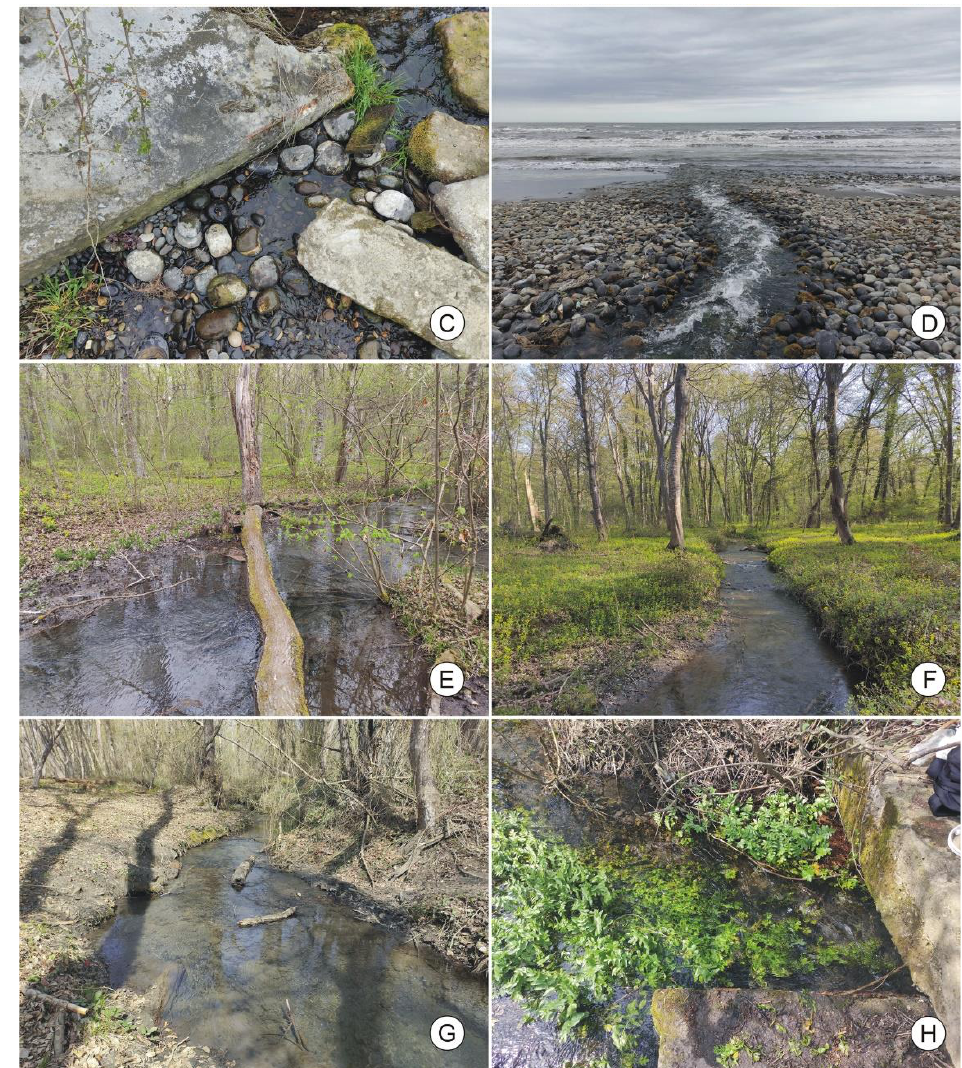
Figure 2. Images illustrating the diversity of biotopes inhabited by Clathrocaspia in the Samur Forest area. ( A ) — One of the channels of the Karasu River (locality Dag01); ( B ) — A fish pond drain at the northern end of Primorskiy village (locality Dag13); ( A – C ) spring by a river on the Caspian Sea coast (locality Dag23); ( D ) — The Yalama River, 30 m above the mouth, on an open beach of the Caspian Sea (locality Dag15); ( E ) — The Yalama River in a lowland forest near Bilbil-Kazmalyar village (locality Dag24); ( F ) — A forest stream, north of Bilbil-Kazmalyar village (locality Dag30); ( A – G ) small forest river (locality Dag21); ( H ) — A forest stream among the bushes on the eastern outskirts of Tagirkent-Kazmalyar village (locality Dag32).